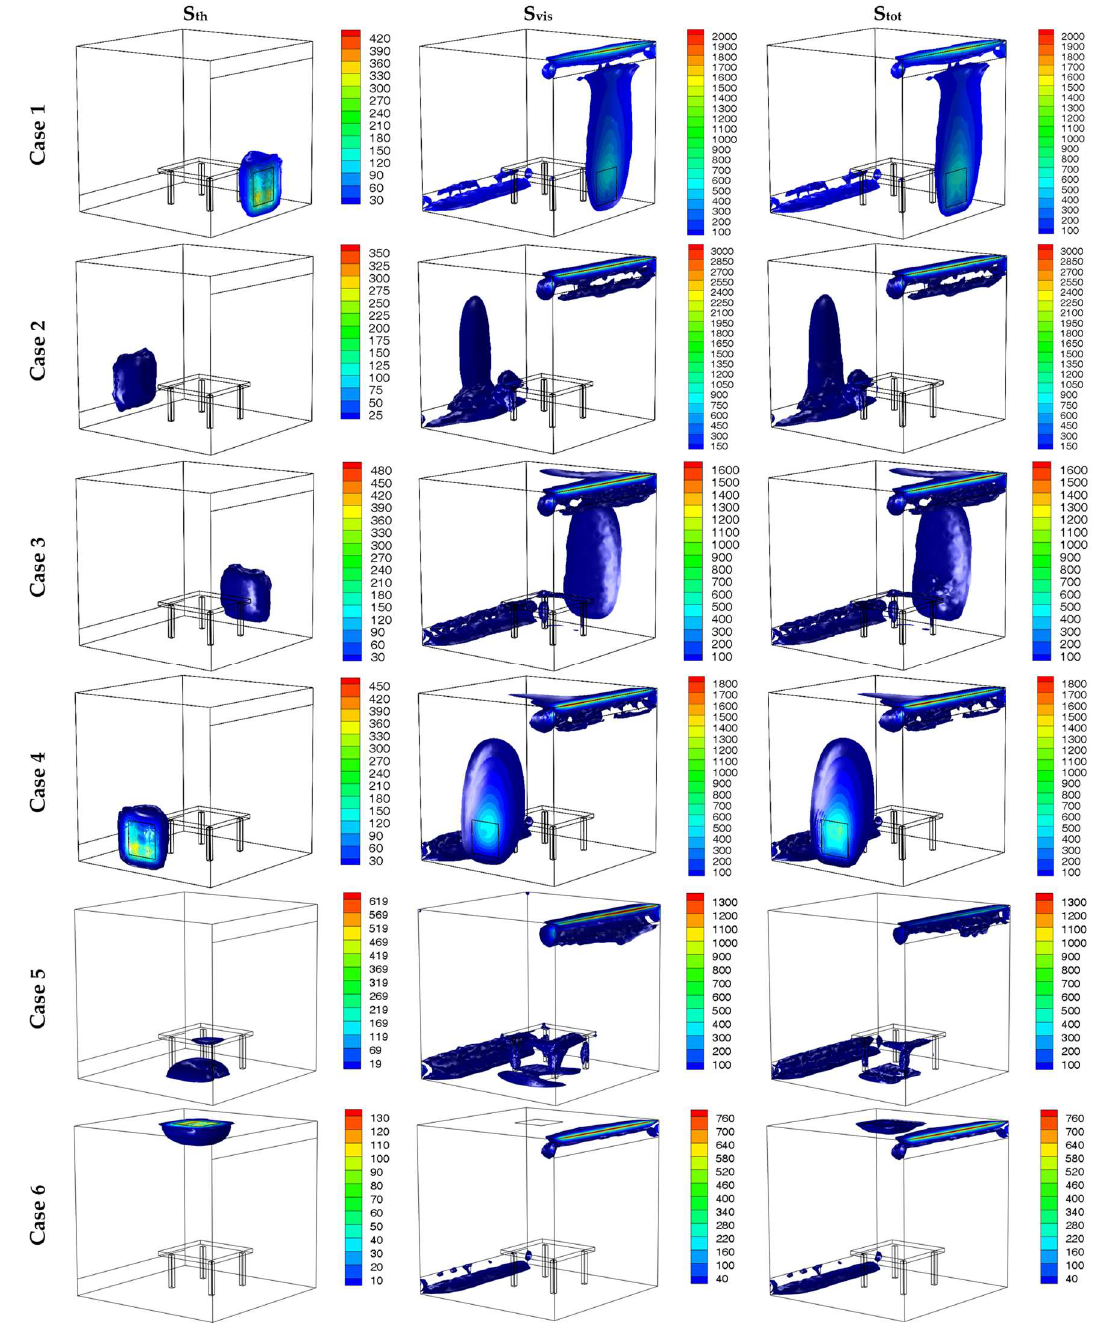
Figure 11. Effect of heat source position on thermal, viscous and total entropy for Ra = 10 5 and I s = 10 −4 .